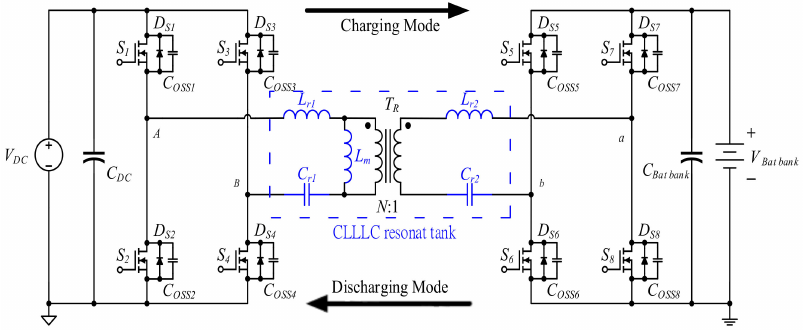
Figure 1. Circuit diagram of the proposed bidirectional CL 3 C full-bridge resonant converter.